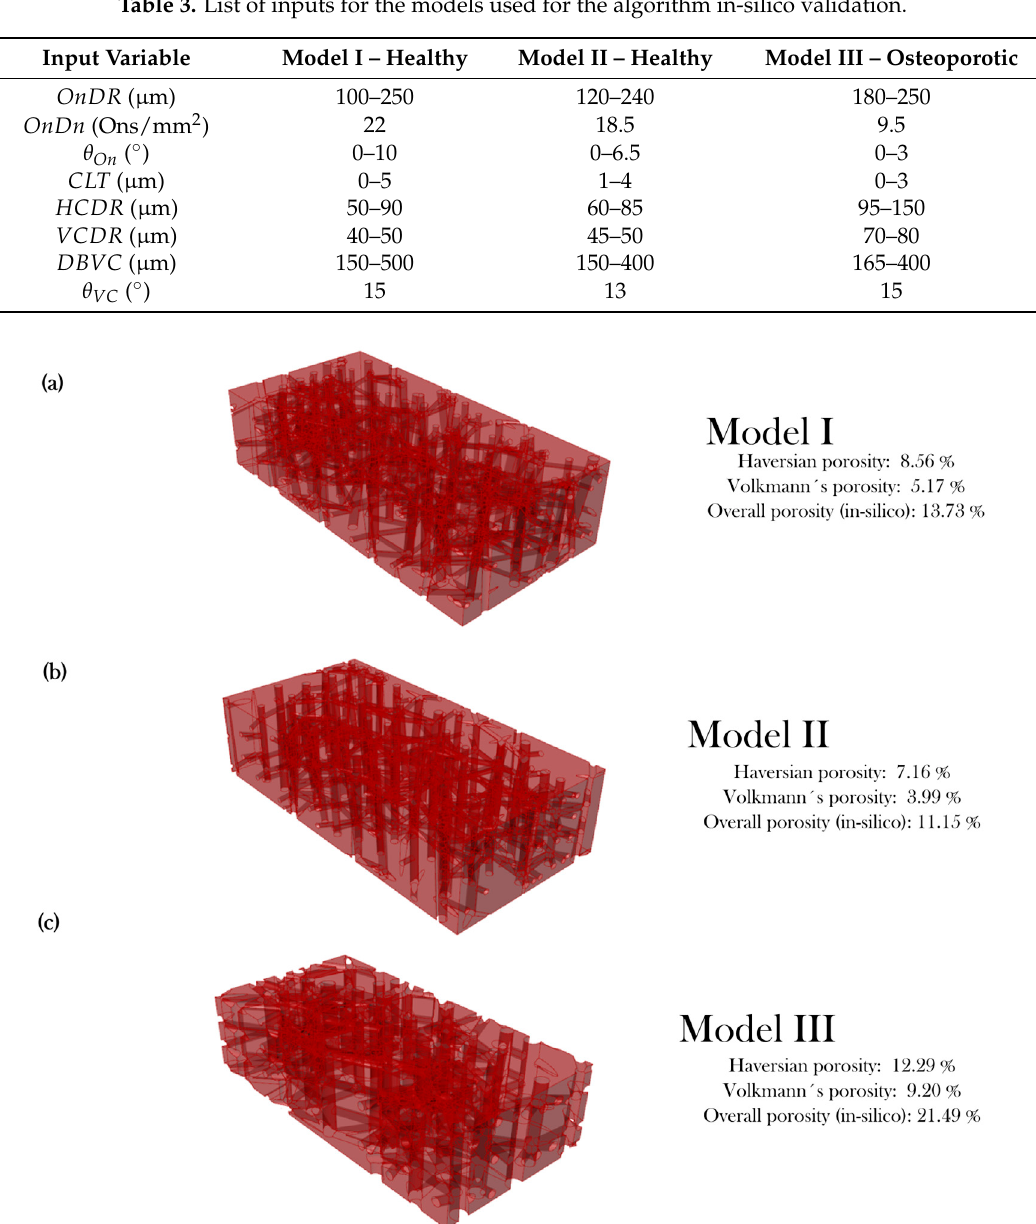
Table 3. List of inputs for the models used for the algorithm in-silico validation.